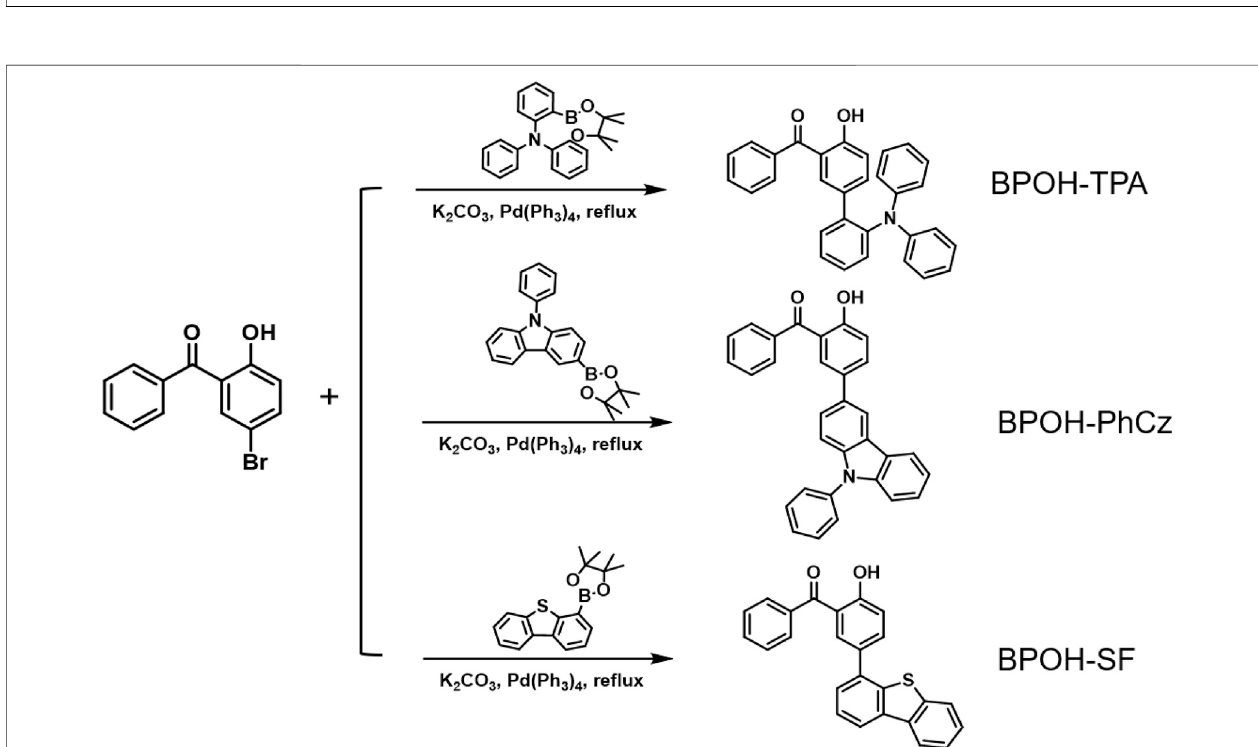
SCHEME 1 | Synthetic routes of compounds BPOH-TPA, BPOH-PhCz and BPOH-SF.